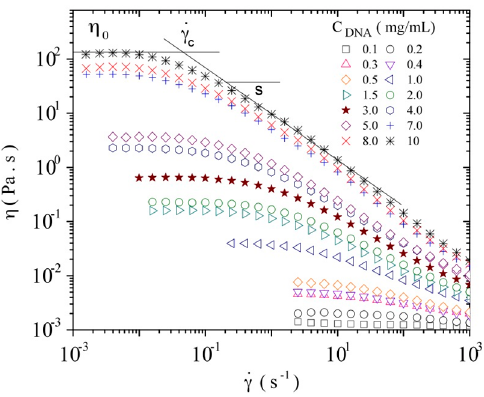
Figure 6. Influence of shear rate on the viscosity of calf-thymus DNA at different DNA concentrations at a temperature of 20 °C in TE buffer.